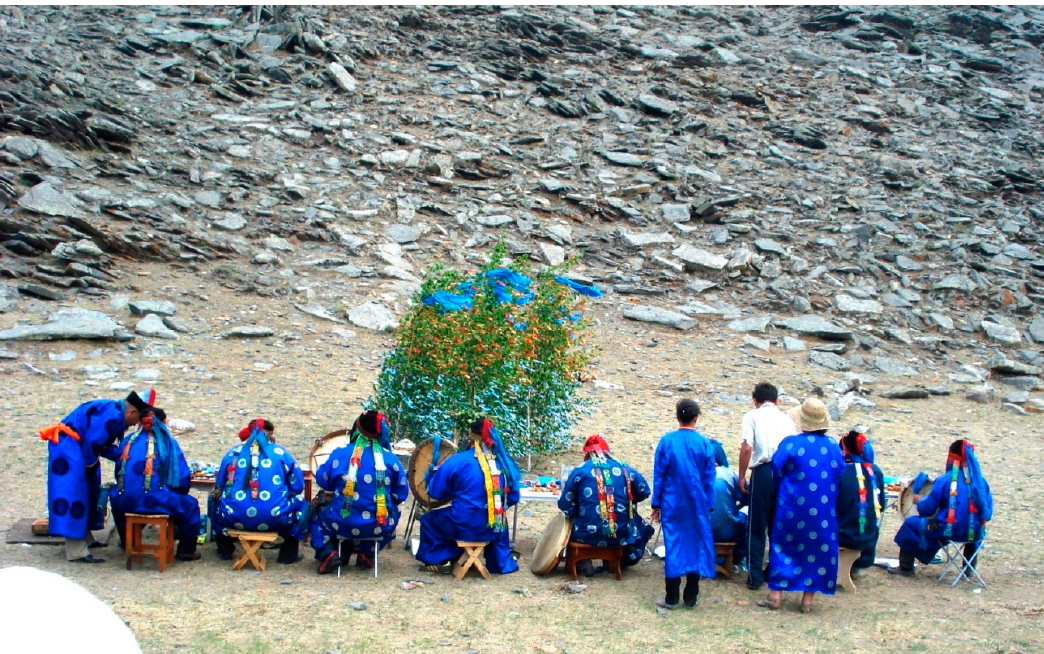
Figure 8. A group of Buryat shamans performing a sacrificial prayer ritual during the “Games of the Yord” at the foot of the hill “Yord” in 2011. Photo: Stefan Krist.